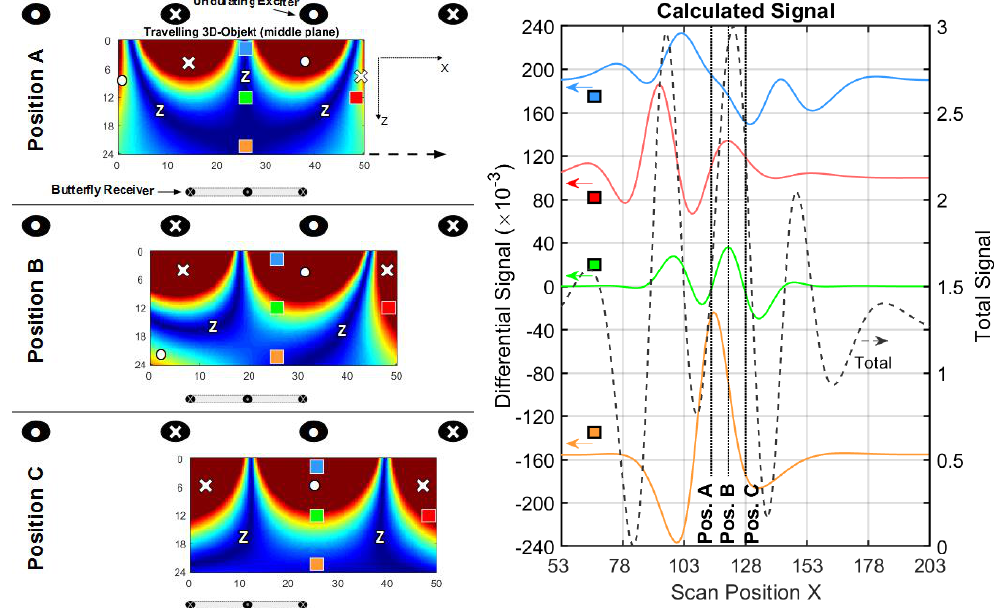
Figure 11. Current and signal calculations with an undulator setup (cf. Figure 3c); ( left ) Eddy current distribution in the horizontal middle plane of a conducting and travelling volume, shown at three characteristic positions A, B and C. Local voids at four characteristic positions inside the travelling volume (blue, green, orange and red squares) are analyzed; ( right ) Total signal (dotted black) and differential signals (blue, green, orange and red lines) for the four voids. T able 6. The main results from the calculated signals, shown in Figure 11. Total Signal Edge Diff. Signal (max. amplitude) (max. amplitude) 1 Ratio between the differential signal and the total signal.